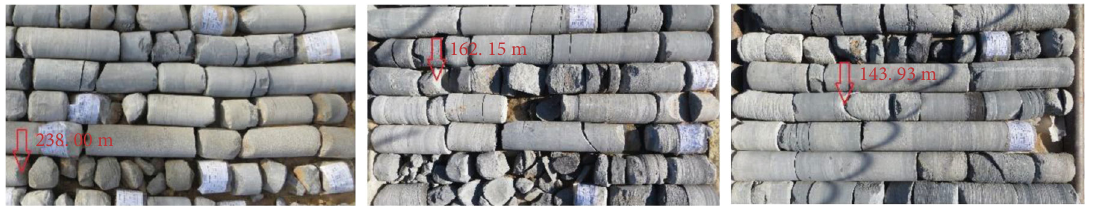
Figure 4: Drill-core photographs of JE1 borehole: (a) RQD is zero of CZ; (b) fi rst fresh vertical fracture and smaller RQD of TFZ; (c) initial high angle fracture and larger RQD of